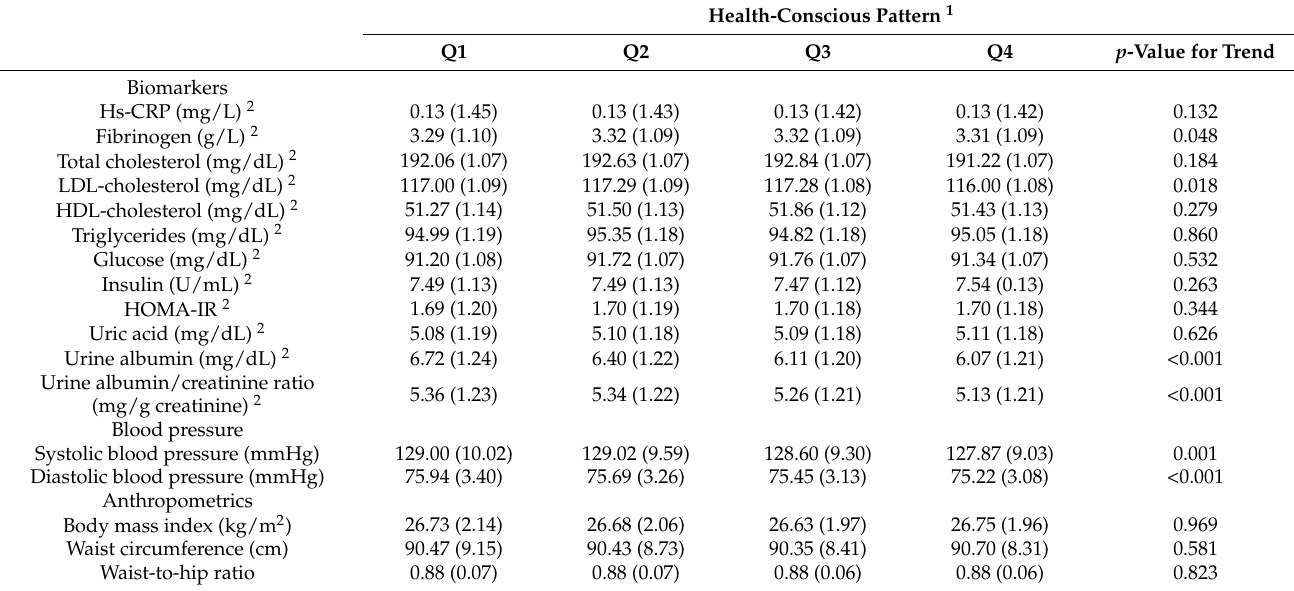
Table 4. Plasma and urine concentrations of inflammatory and cardio-metabolic biomarkers, blood pressure, and anthropo- metrics according to the quartiles of the health-conscious pattern 1